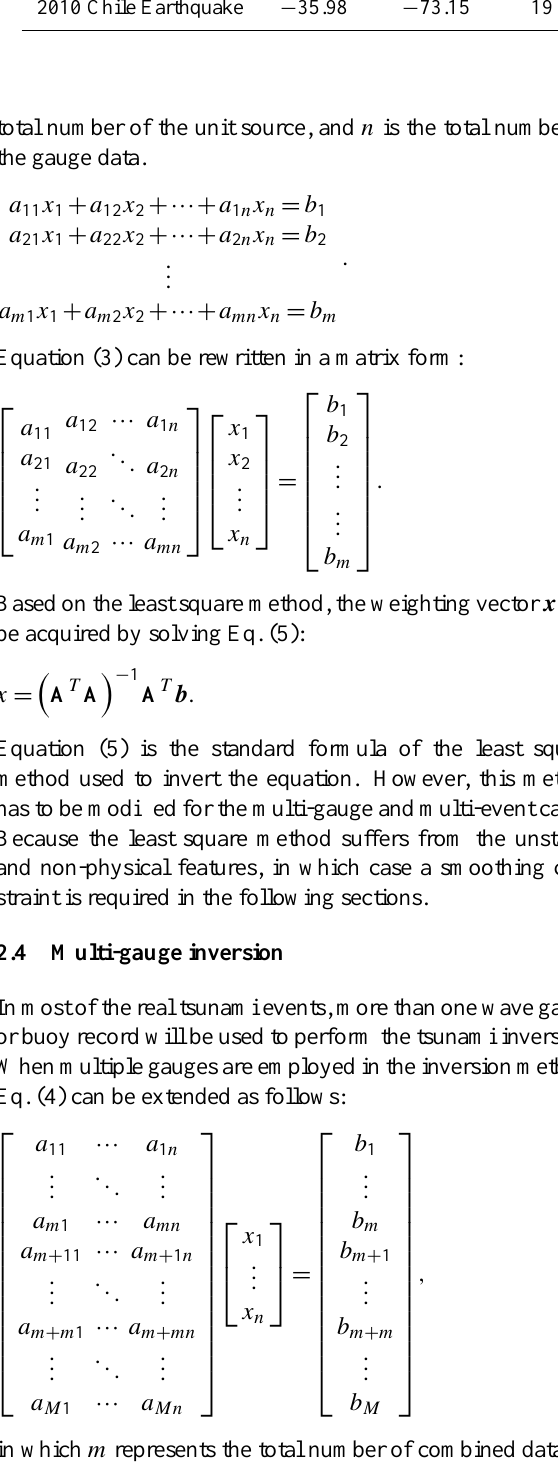
Table 1. The fault parameters of fictitious earthquake and 2010 Chile earthquake. Latitude Longitude Strike Dip Slip Depth Length (centroid) Width Dislocation (E) (N) (deg.) (deg.) (deg.) (km) (km) (km) (m) Fictitious Earthquake 119.5 21.5 165 30 − 76 19.6 35.77 17.88 2 2010 Chile Earthquake − 35.98 − 73.15 19 18 116 23.2 500